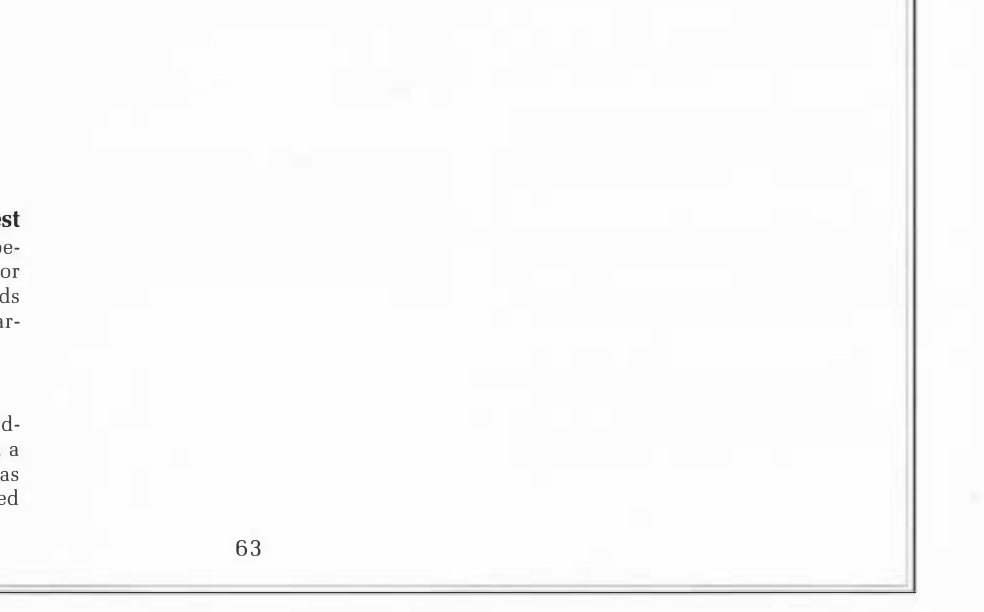
Figure 1 An Institute student, Gillian Nason, at work in one of the conservation lab­ oratories. She is cleaning and consolidating mortar, containing impressions of human footprints, that underlaid a mosaic floor in a Byzantine church at Deir ain Abata,